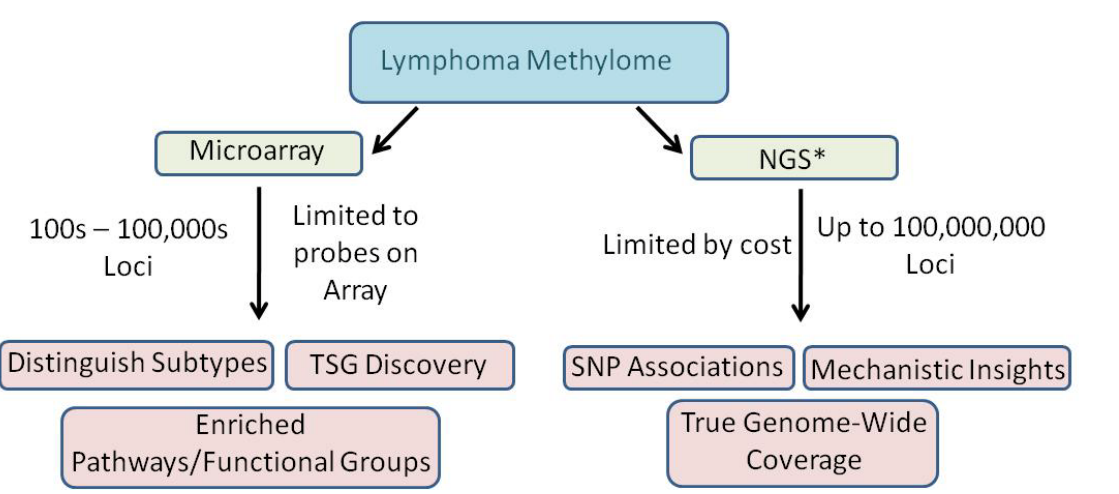
Figure 5. Microarray versus NGS in lymphoma methylation studies. NGS: Next- generation sequencing; TSG: tumor suppressor gene; SNP: single nucleotide polymorphism. * NGS includes all outcomes of microarray in addition to the outcomes presented in the